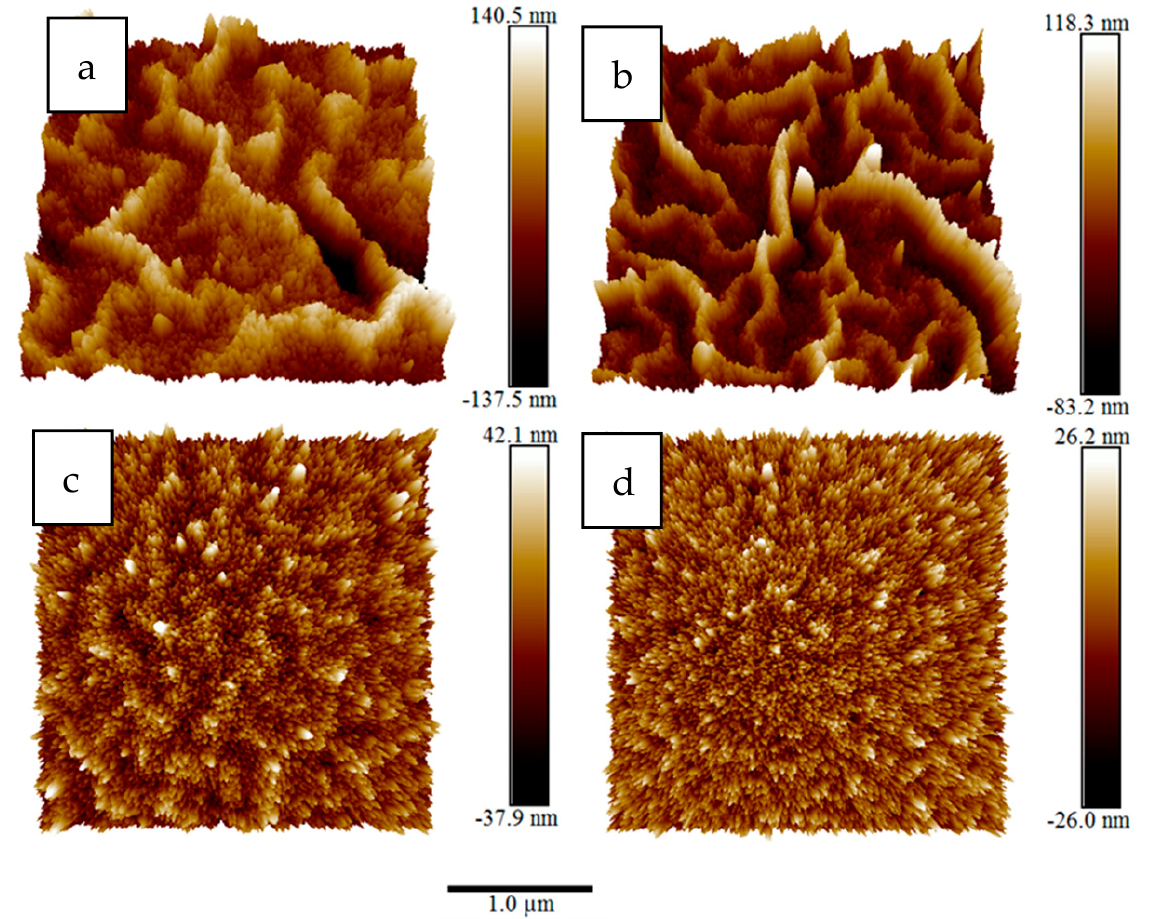
Figure 9. Three-dimensional AFM images of ZnO films coated at different spinning speeds: ( a ) 2000 rpm, ( b ) 2500 rpm, ( c ) 3000 rpm and ( d ) 3500 rpm.